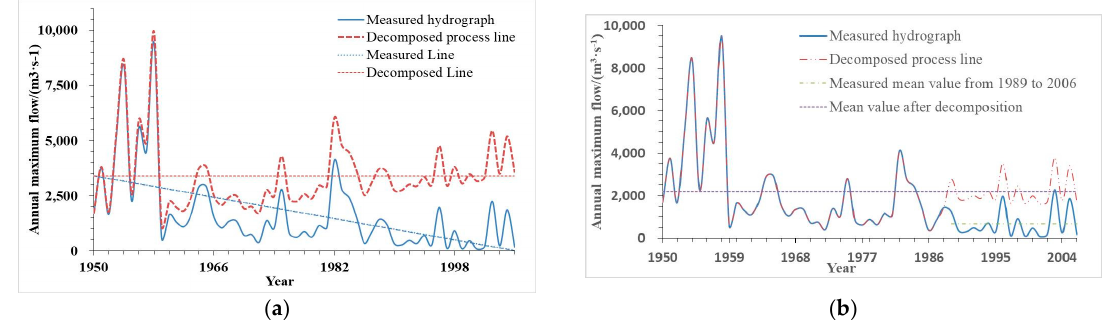
Figure 6. Time series before and after decomposition. ( a ) Trend, ( b ) jump.